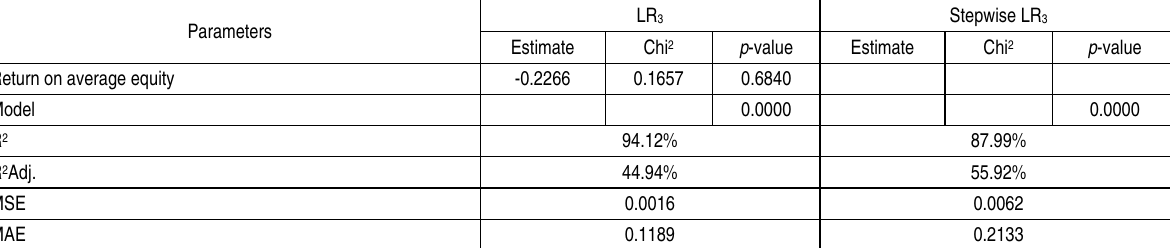
Prediction Capability Plot for Model3